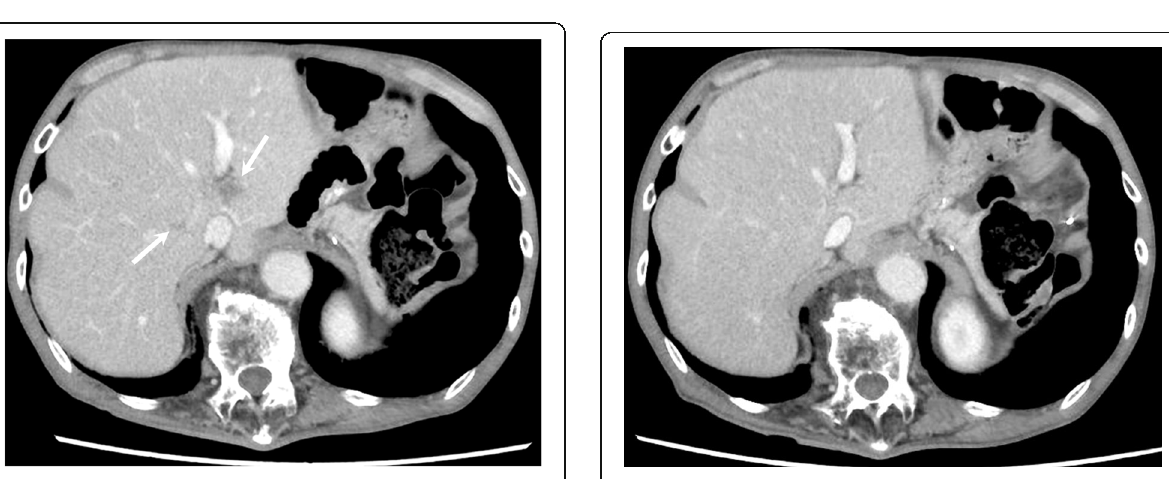
Fig. 4 Abdominal computed tomography (CT) findings after 12 cycles of nivolumab. No liver mass lesions are seen on abdominal enhanced-contrast